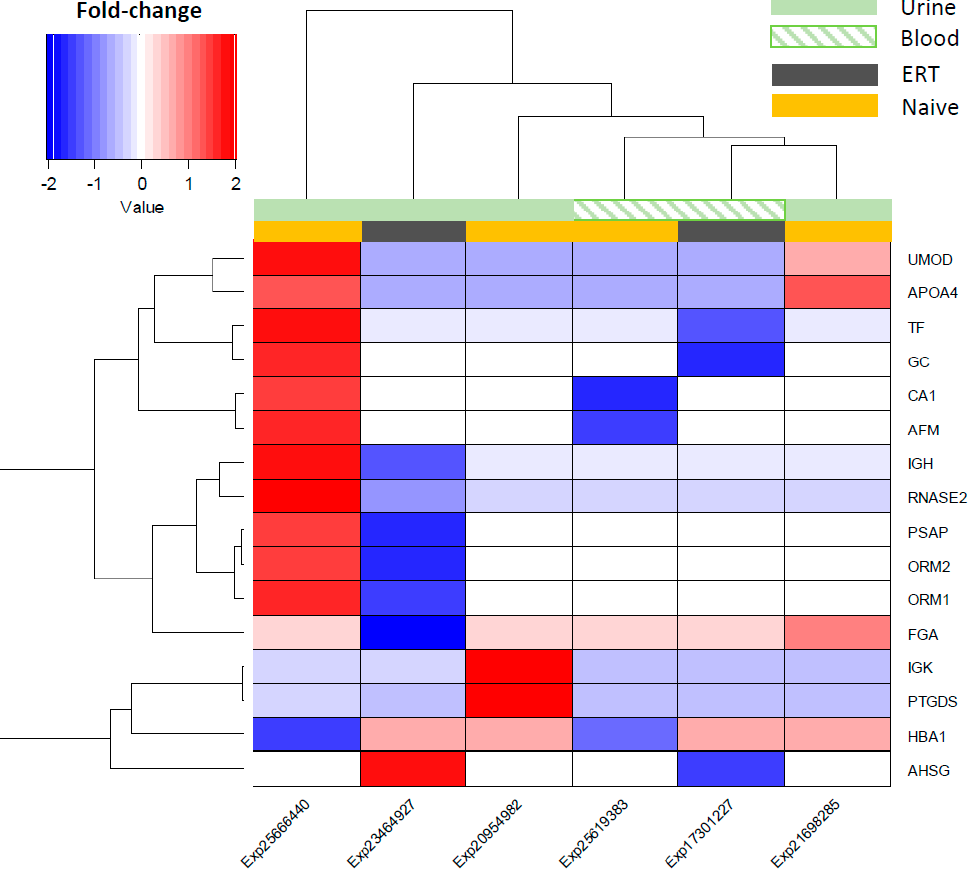
Figure 3. Hierarchical clustering of the differential molecular expression across Fabry studies and by fluid source. Decreased expression shown in a blue and increased expression by the red colour gradient. Group modulation for the urine fluid source is shown as light green in a block, whereas for the blood it is presented as a light green pattern. Group modulation representing the type of treatment is shown as dark-grey blocks for ERT patients and light-orange blocks for the non-treated patients (naïve group).